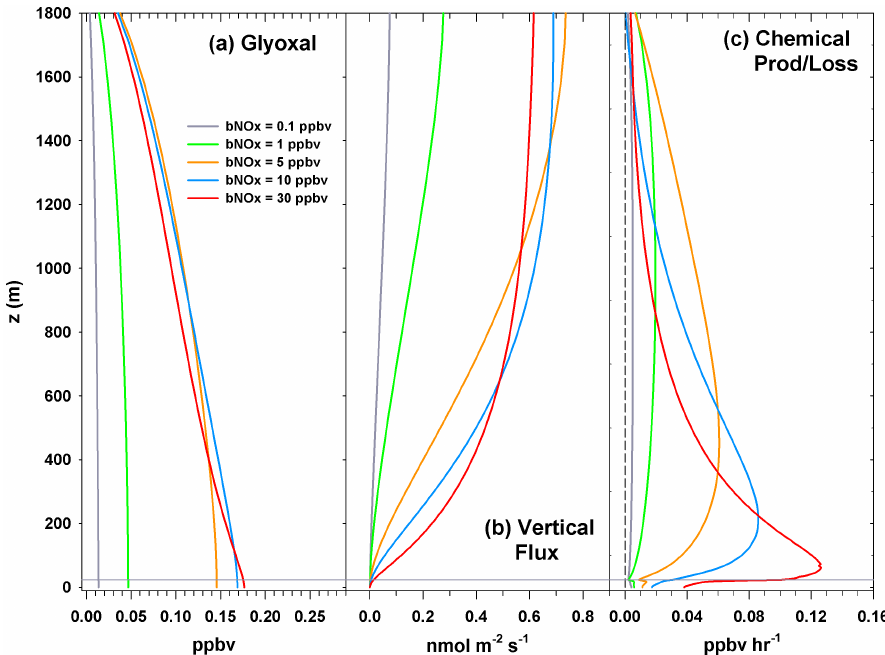
Fig. 11. Vertical profiles of glyoxal (a) mixing ratio (ppbv), (b) vertical flux (nmolm − 2 s − 1 ) , and (c) chemical production or loss (ppbvh − 1 ) for each background NO x value (horizontal gray line is canopy top